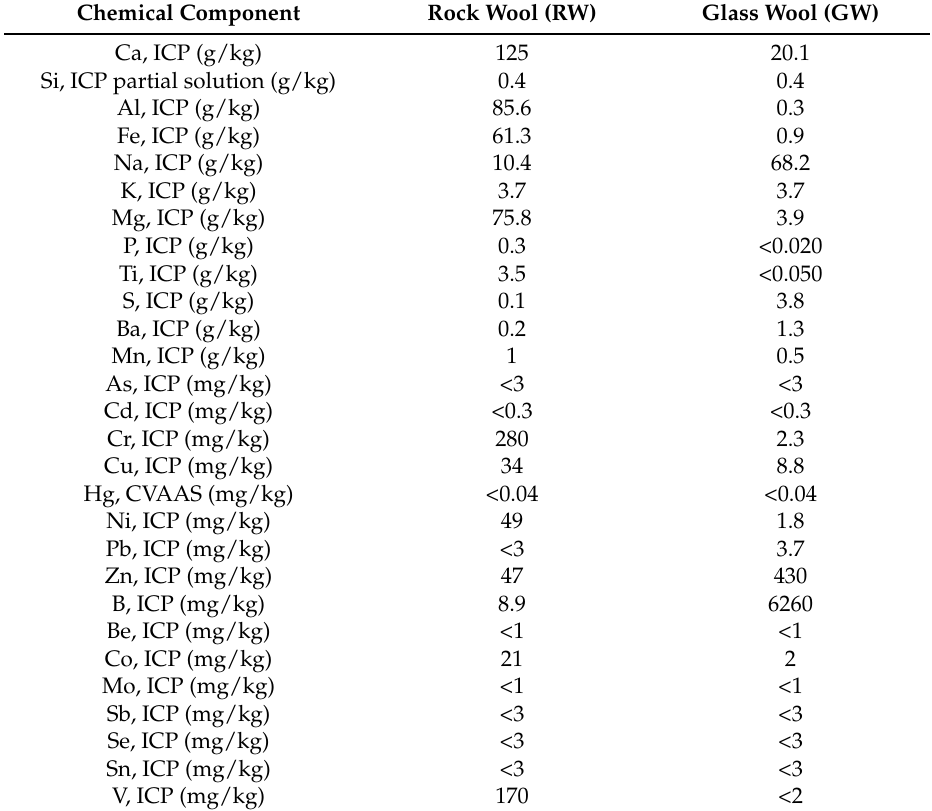
Table 2. The chemical composition of rock wool (RW) and glass wool (GW), determined by ICP-OES. Chemical Component Rock Wool